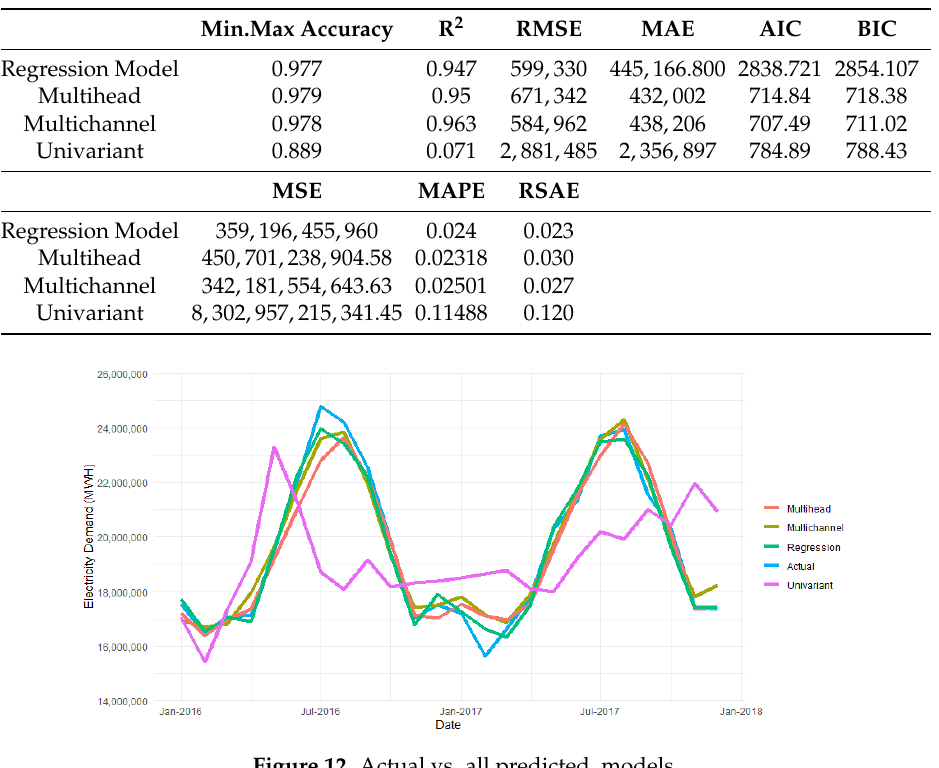
Figure 12. Actual vs. all predicted